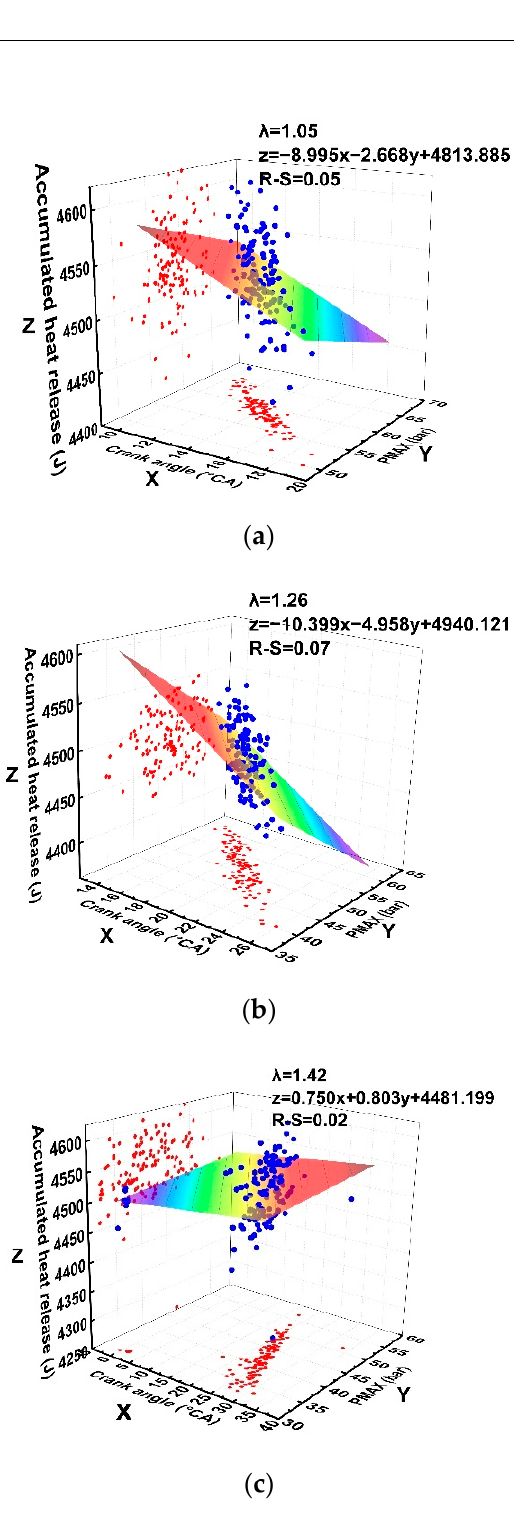
Figure 7. Fitting of accumulated heat release and PMAX distribution under different λ : ( a ) The fitting of accumulated heat release and PMAX at λ = 1.05; ( b ) The fitting of accumulated heat release and PMAX at λ = 1.26; ( c ) The fitting of accumulated heat release and PMAX at λ =